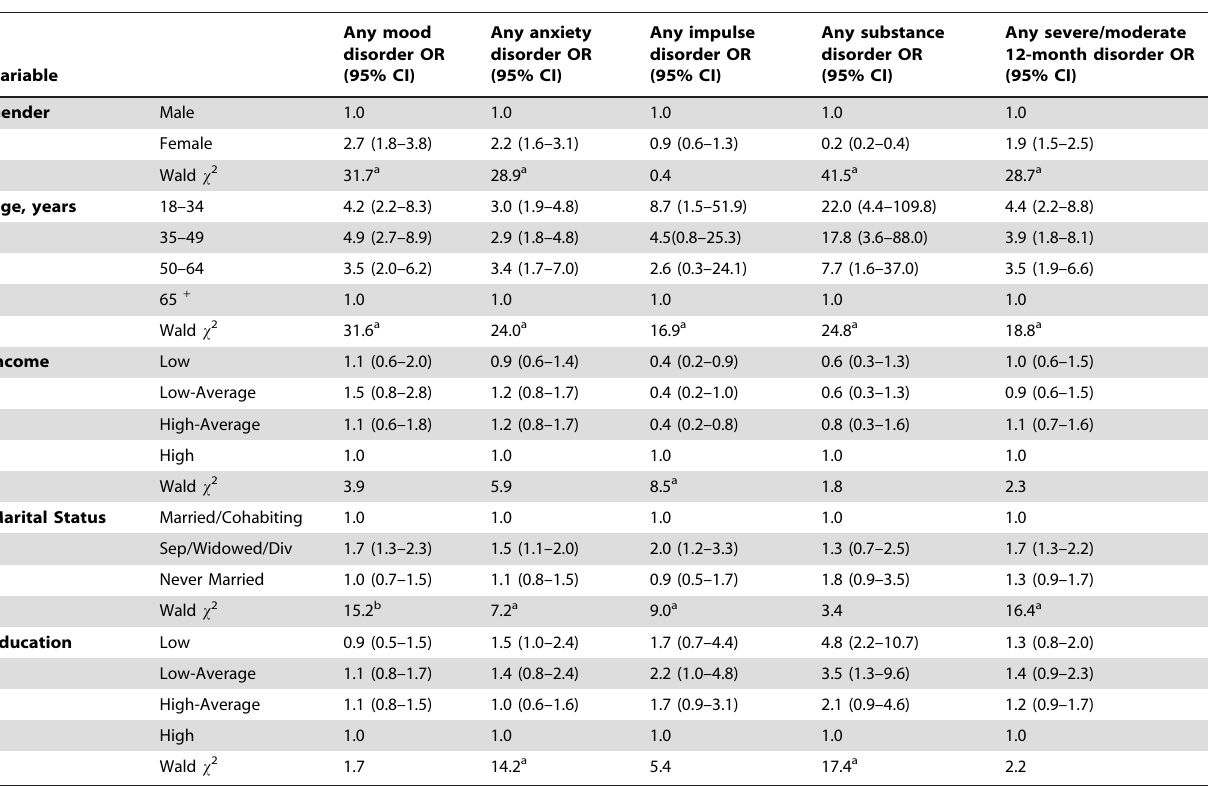
Table 2. Socio-demographic correlates of summary categories of 12-month DSM-IV/WMH-CIDI disorders, and severity.